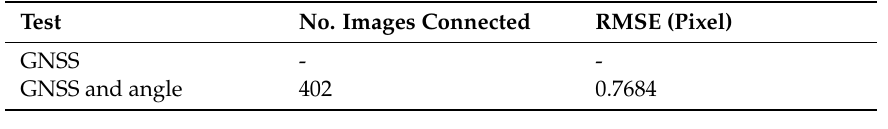
Table 7. Image orientation result for the test site (“-” stands for failure).